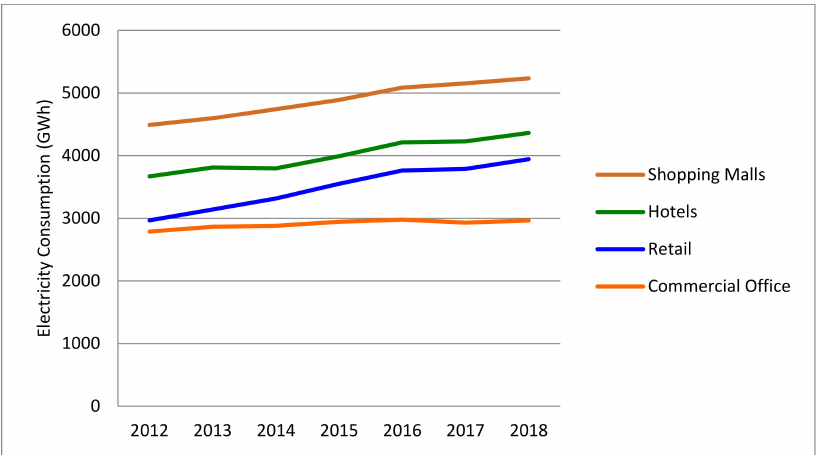
Figure 2. Total electricity consumption by building type in Thailand 2012–2018 [21].